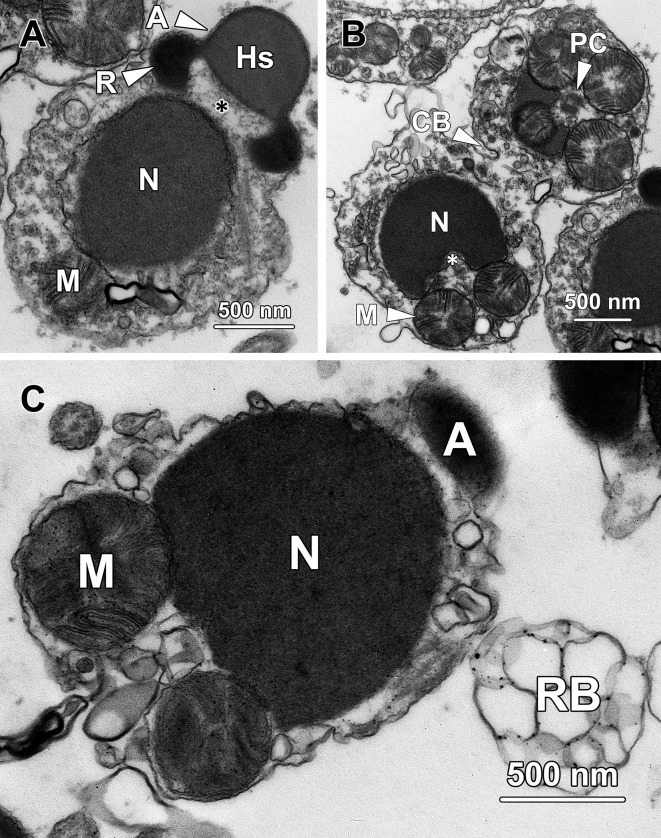
Transmission electron micrographs of step 10 spermatids.(A) The oval nucleus (N) is occupied by fully condensed homogeneous granular chromatin. The acrosome (A) reaches the anterior apex of the cytoplasm in step 10 spermatids, opposite to the pole where the mitochondria (M) and flagellum reside. As the dark particles spread throughout the ring-like structure, the ring appears darker than the central hemisphere. (B) Early step 10 spermatids remain in pairs and are interconnected by a cytoplasmic bridge (CB). The cytoplasm contains clusters of irregular-shaped vesicles, indicating the continuous formation and expulsion of residual bodies. The formation of mitochondrial sheath is accomplished, with four spherical mitochondria (M) surrounding the proximal centriole (PC). *, implantation fossa. (C) In late step 10 spermatids, numerous clusters of irregular-shaped vesicles are found inside and adjacent to the cytoplasm, suggesting the discharge of residual bodies (RB) occurs dramatically at this stage. With the elimination of excess cytoplasm, the cytoplasmic bridge connecting the spermatids disintegrates, resulting in the formation of two independent spermatozoa. A, acrosome; M, mitochondria; N, nucleus.